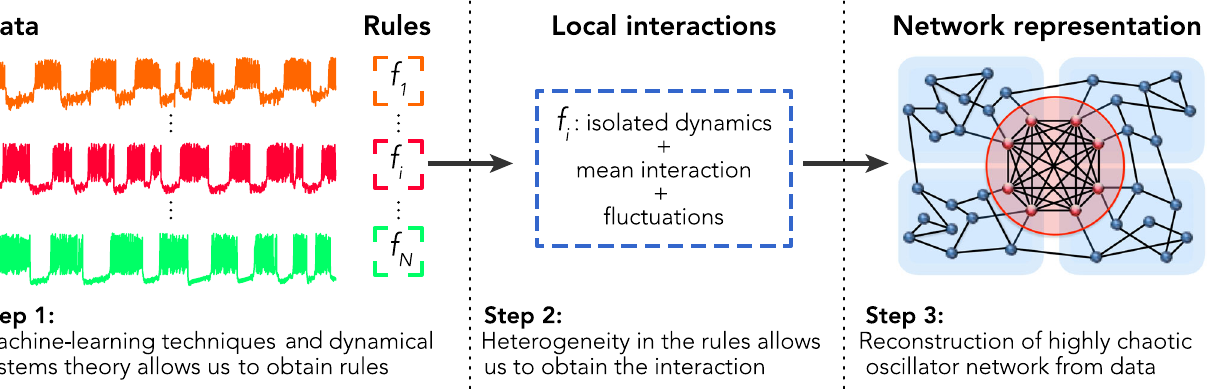
FIG. 7. Reconstruction scheme with the effective network. From the time series, we build a model for the local evolution f node. Under the assumption that such rules change from node to node depending on their connectivity, we estimate the coupling function. Using the fluctuations of the time series with respect to the low-dimensional rules, we recover the community structures. Gathering all this information, we obtain an effective network that can be used to predict critical